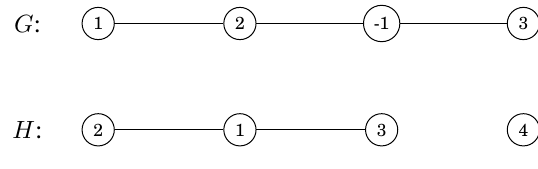
Figure 8: Examples of sum graphs.